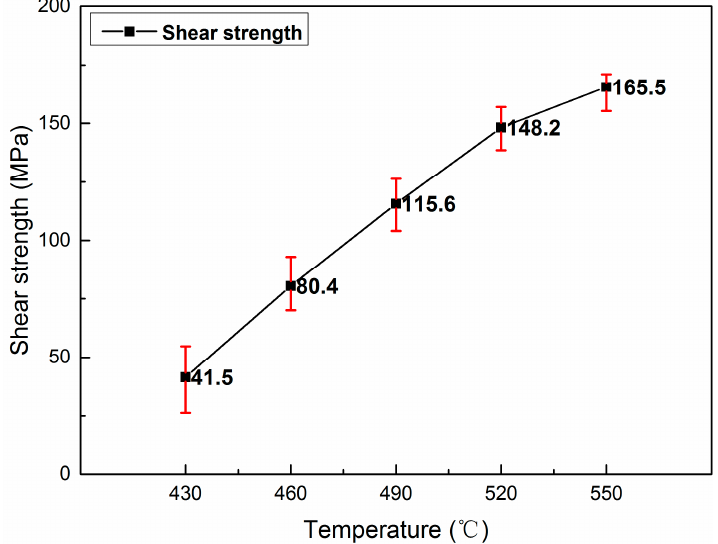
Figure 5. Shear strength of the joints which bonded under different temperatures (6 MPa–60 min).